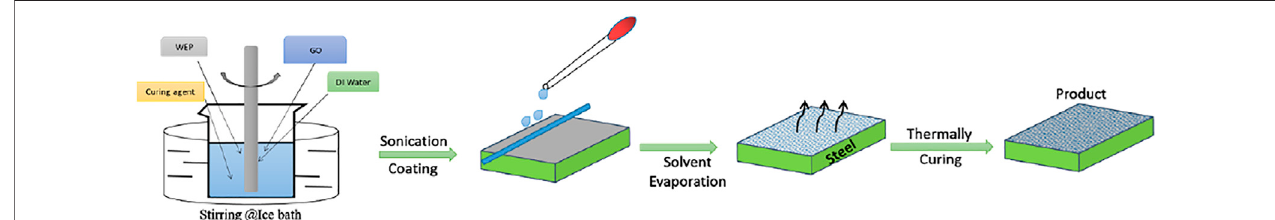
FIGURE 1 | Schematic illustration of the GOWE coating preparation.